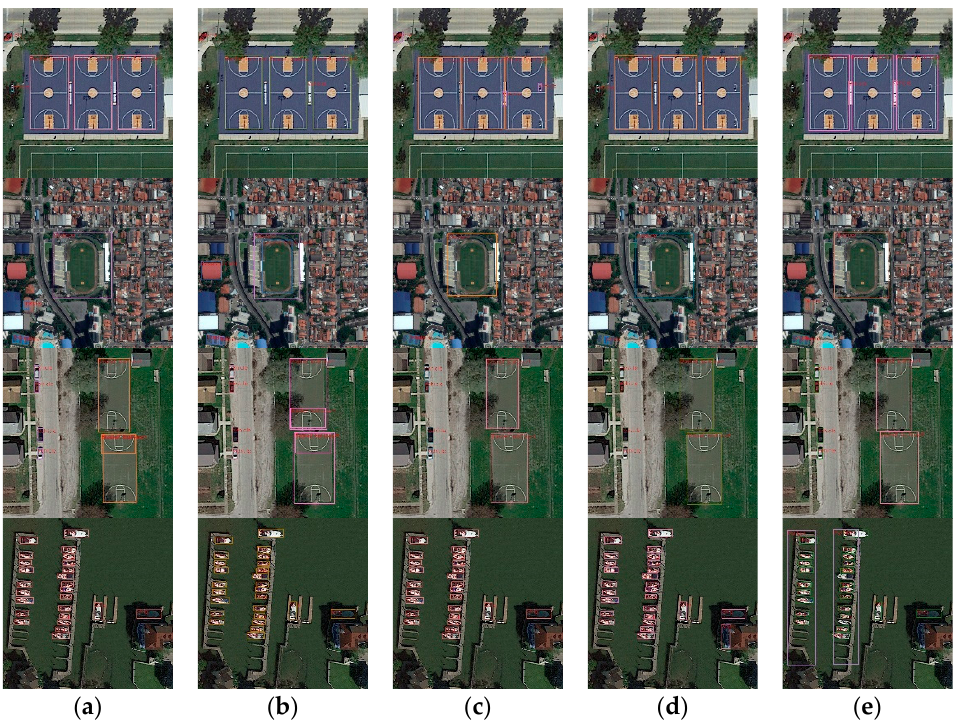
Figure 12. Prediction results comparison between Faster Rcnn, FPN, RetinaNet, YoloV4, and proposed method. ( a ) Faster Rcnn; ( b ) FPN; ( c ) RetinaNet; ( d ) YoloV4; ( e )